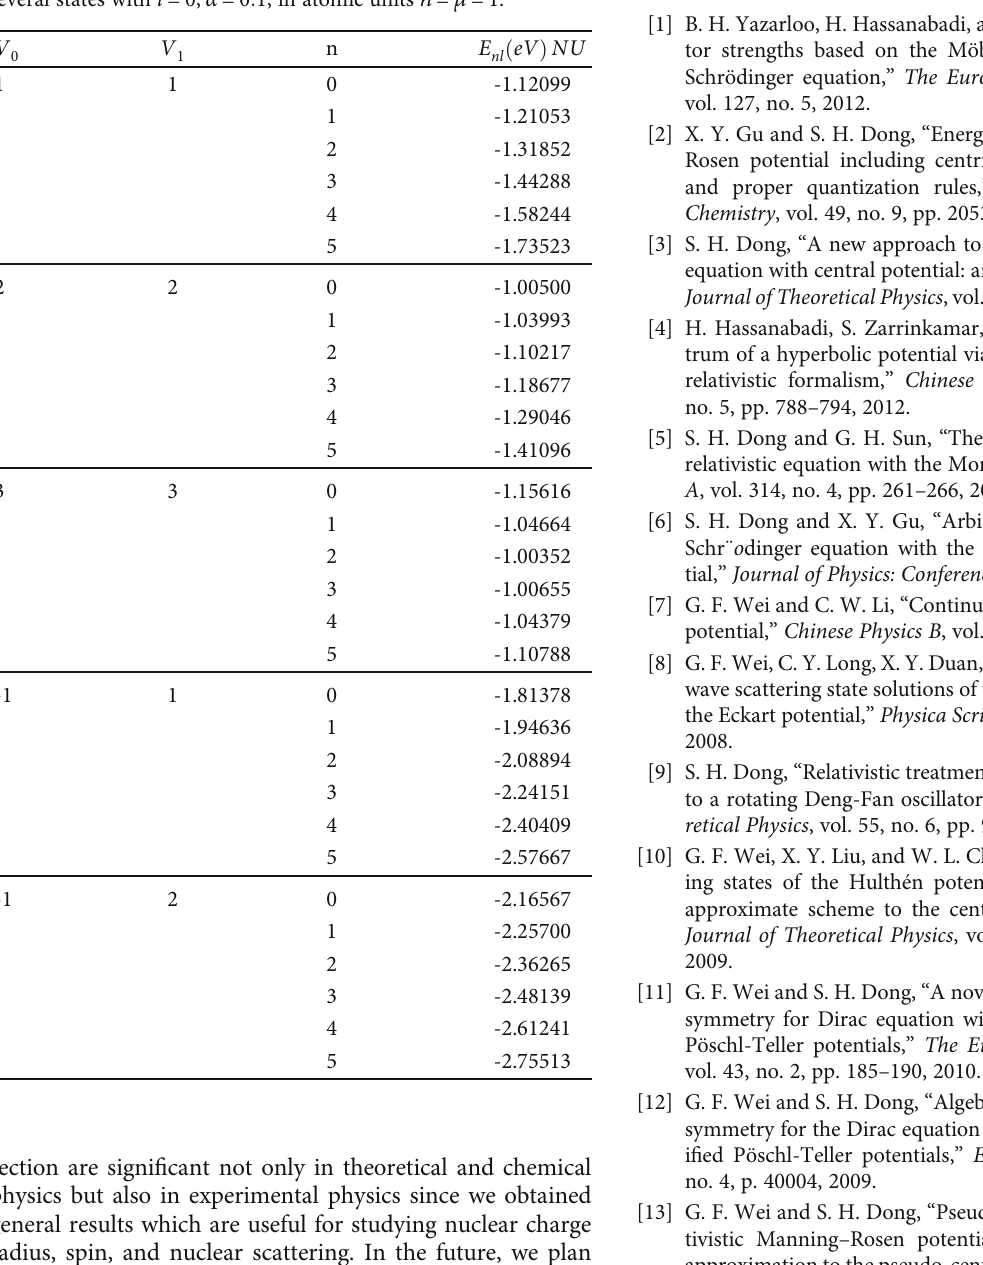
Table 4: The energy levels of the Eckart plus Hulthen potential for several states with l = 0, α = 0 : 1 , in atomic units ℏ = μ = 1